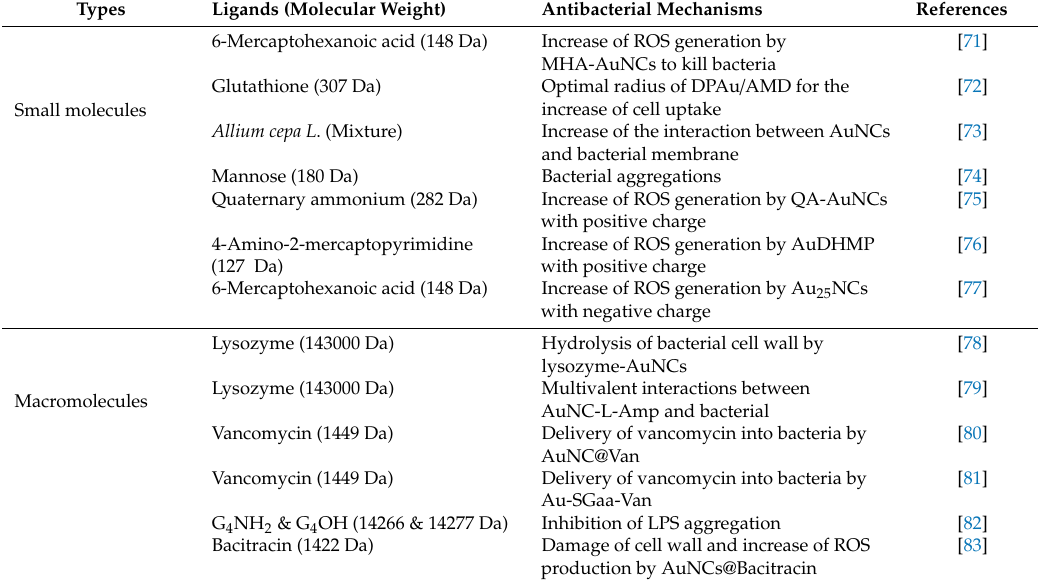
Table 1. Ligands and antibacterial mechanisms of AuNCs in this